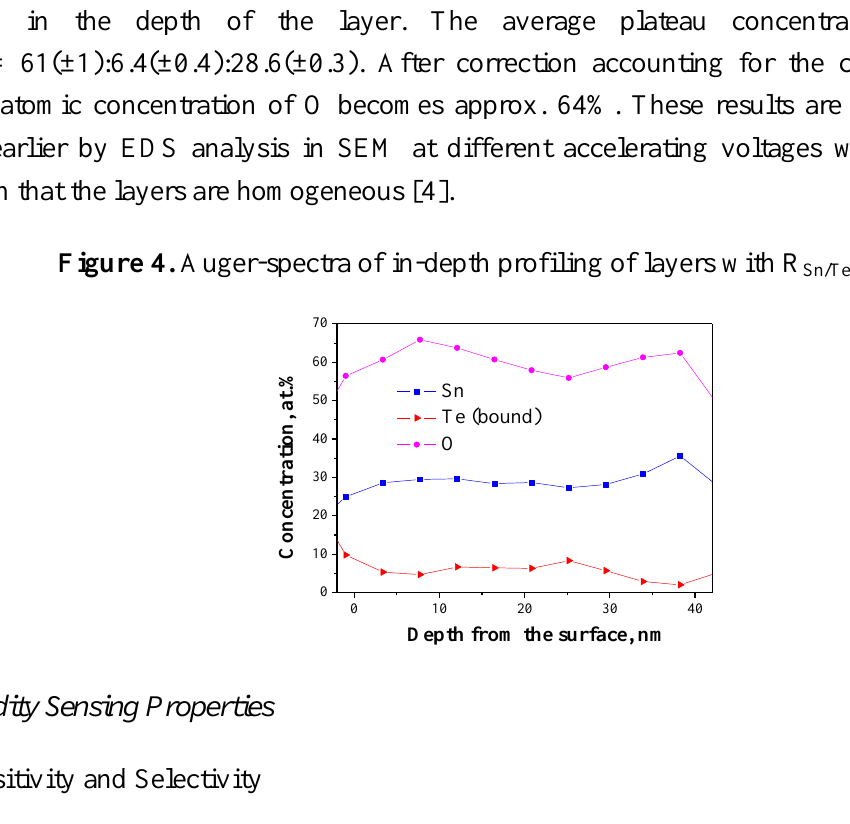
Figure 4. Auger-spectra of in-depth profiling of layers with R